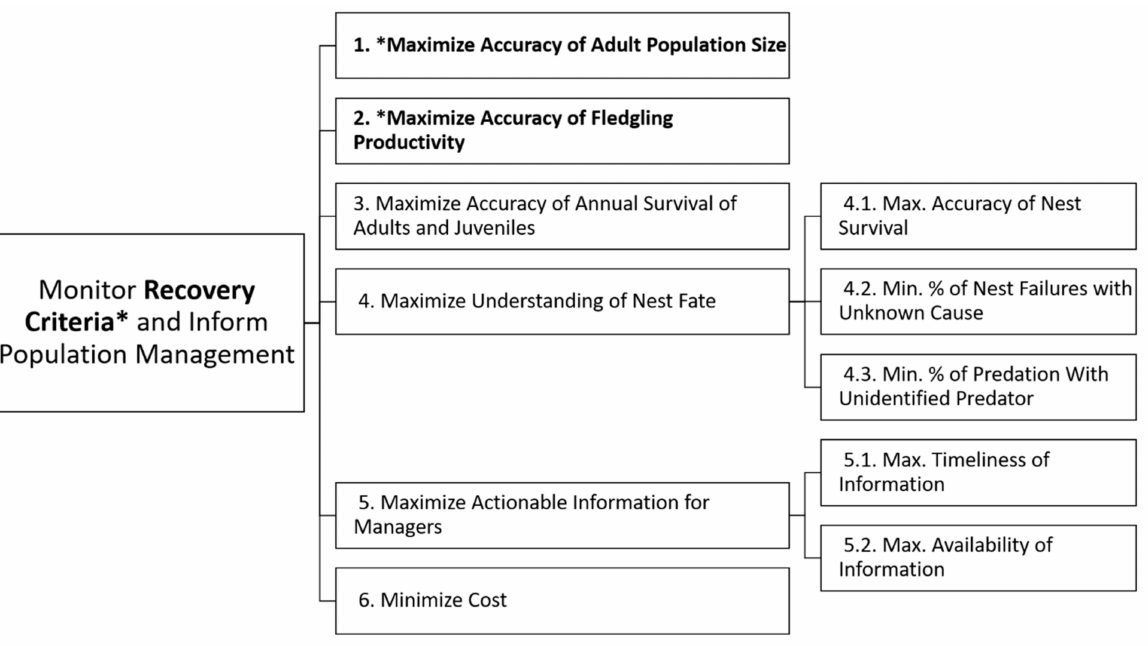
Figure 2. Hierarchy of objectives for monitoring Western snowy plovers. The hierarchy was created by a technical review team representing decision makers and stakeholders. The hierarchy has six fundamental objectives and two of the objectives have sub-objectives. See Table 1 for the weight scenarios which were investigated. Recovery criteria are indicated with an asterisk